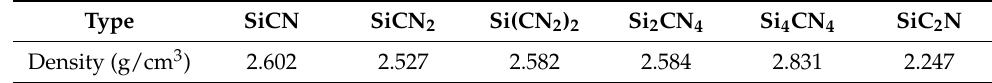
Table 1. Densities of annealing models of a-SiC x N y